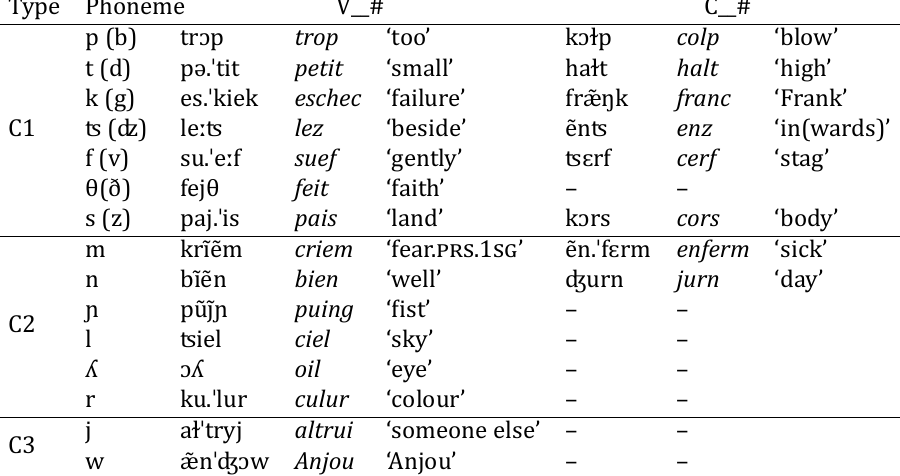
‘receive.(cid:277)(cid:279)(cid:280).1(cid:280)(cid:268)’ and recei v ent [rə.ˈʦej. v ət] ‘receive.(cid:277)(cid:279)(cid:280).3(cid:277)(cid:273)’. All type